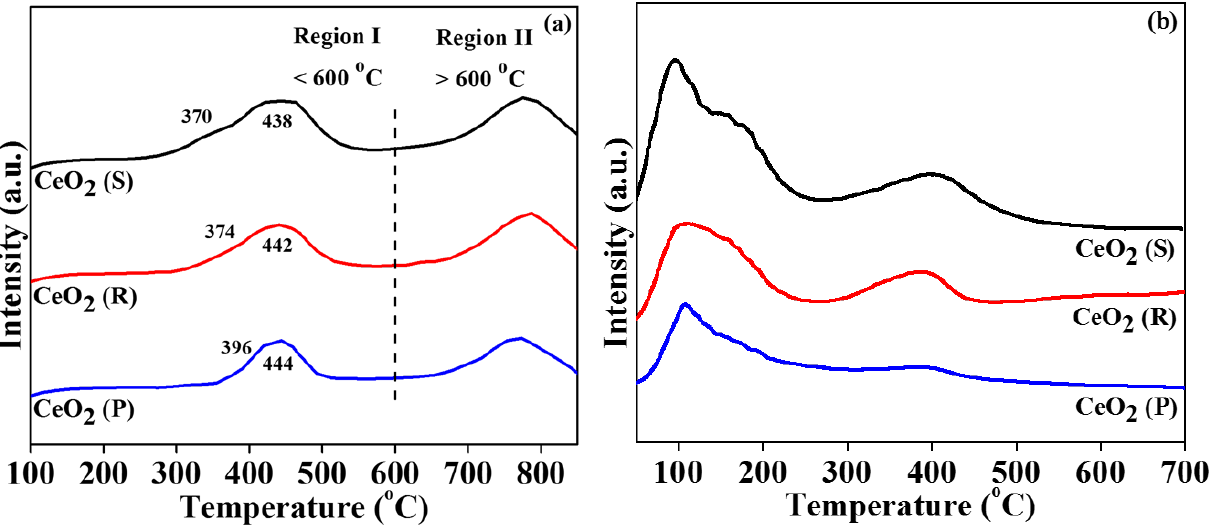
Figure 4. H 2 -TPR ( a ) and O 2 -TPD ( b ) profiles of CeO 2 (S), CeO 2 (R) and CeO 2 (P).